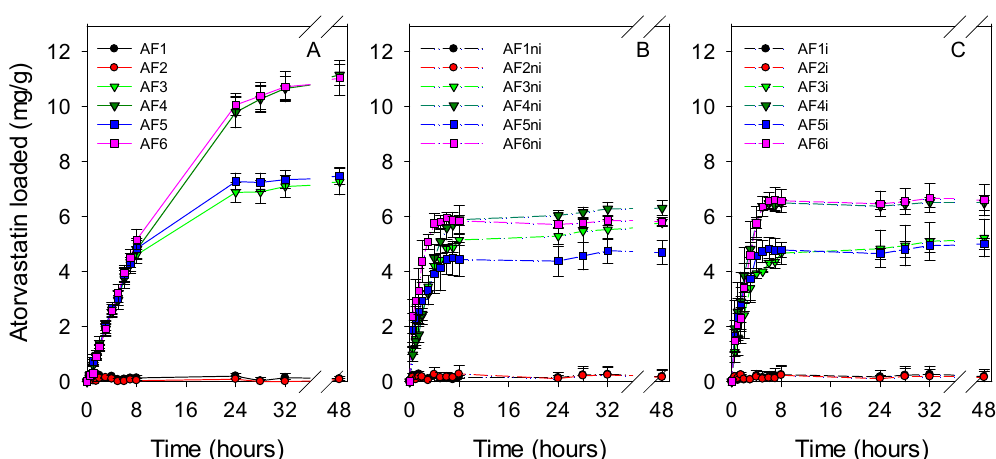
Figure 4. Atorvastatin loading profiles of all hydrogels (( A ) first set of hydrogels; ( B ) nonimprinted hydrogels and ( C ) imprinted hydrogels) soaked in 10 mL of atorvastatin solution (0.04 mg/mL in ethanol:water 20:80 v/v ) at room temperature under magnetic stirring (150 rpm) for 48 h. Hydrogel codes as in Table 1 ( n = 4; mean values and standard deviations).